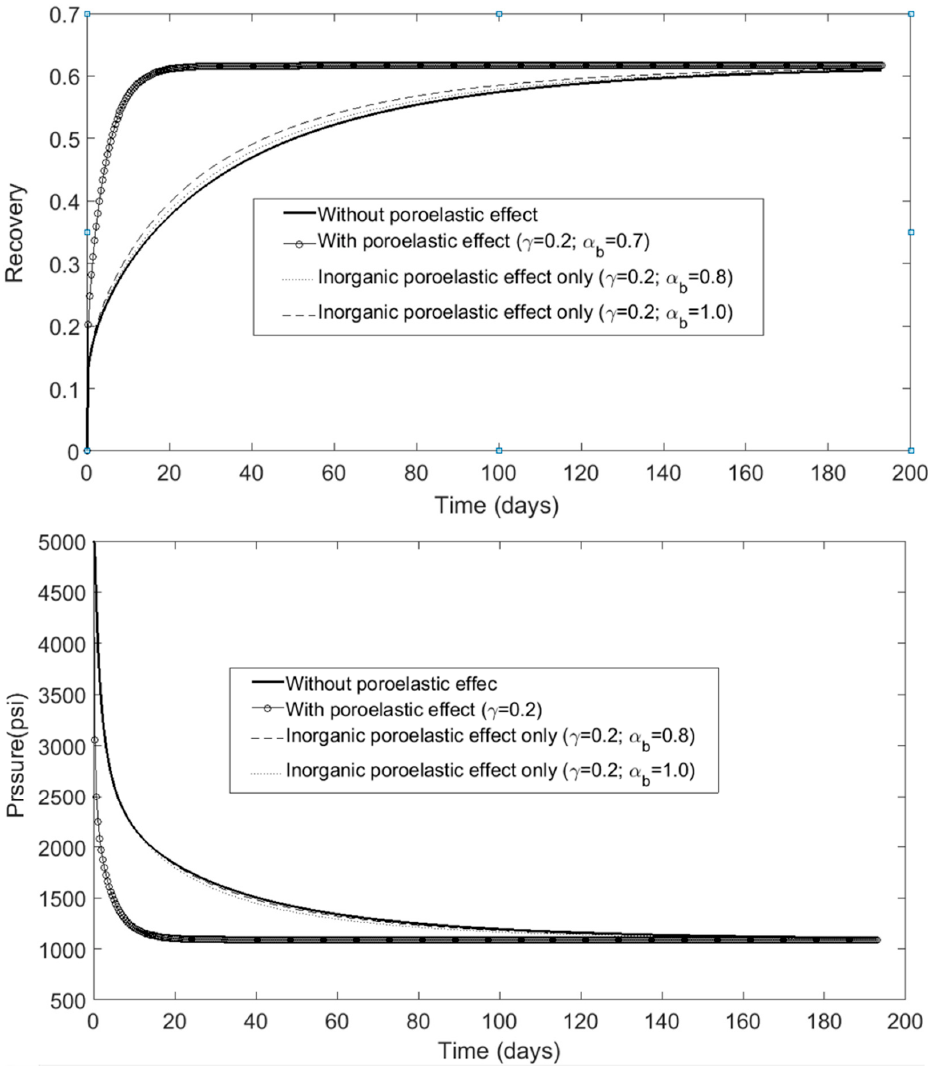
Figure 8. Impact of changes in Biot’s coefficient on pressure decay ( bottom ) and ultimate recovery ( top